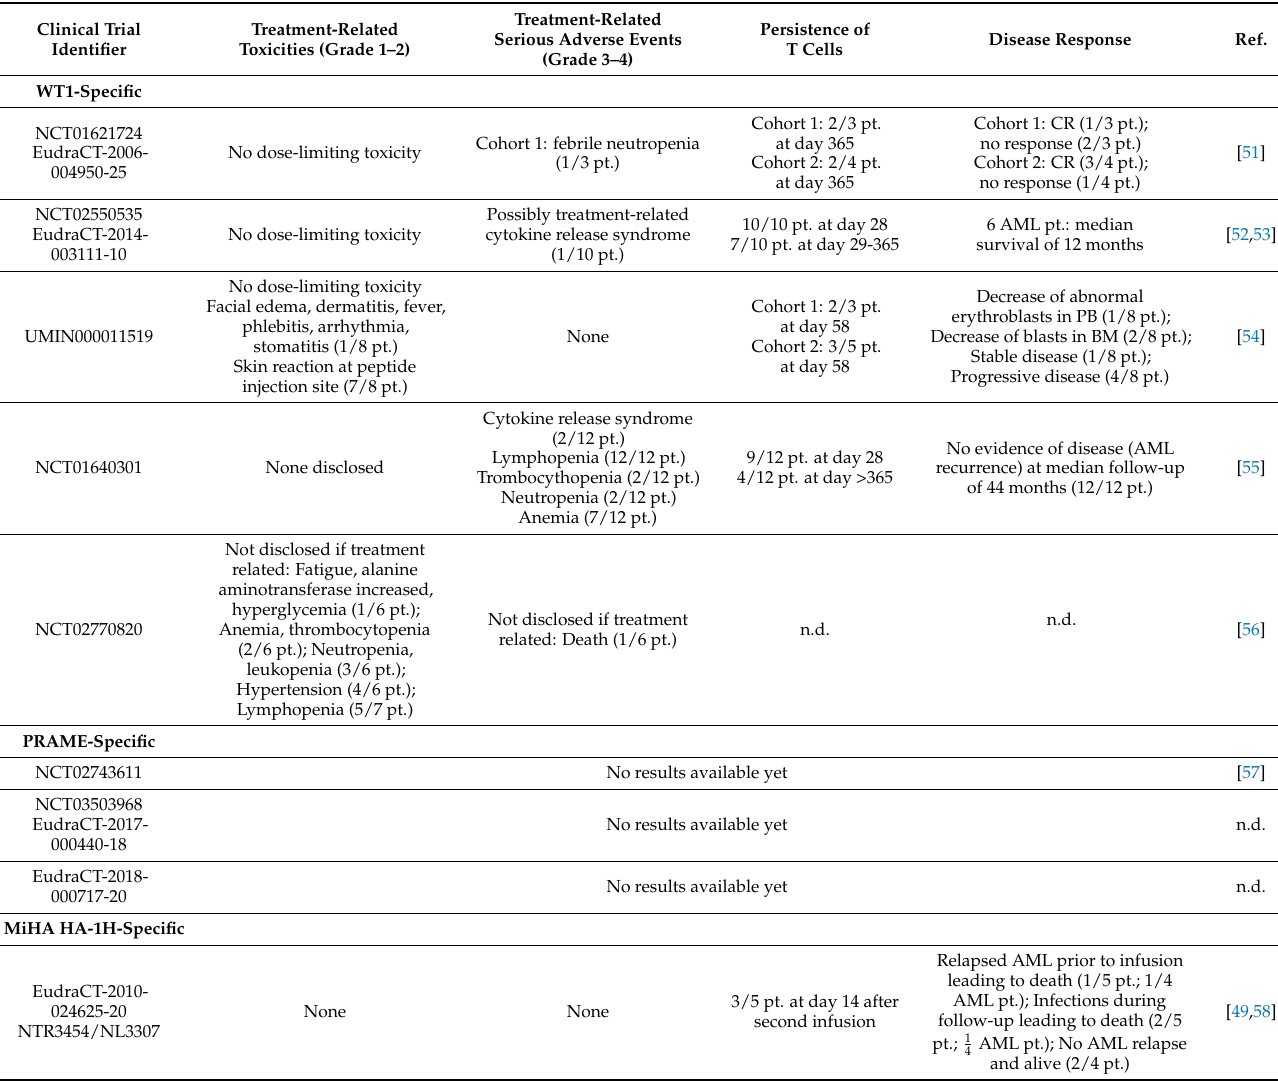
Table 4. Outcomes of clinical trials using TCR-T cells for